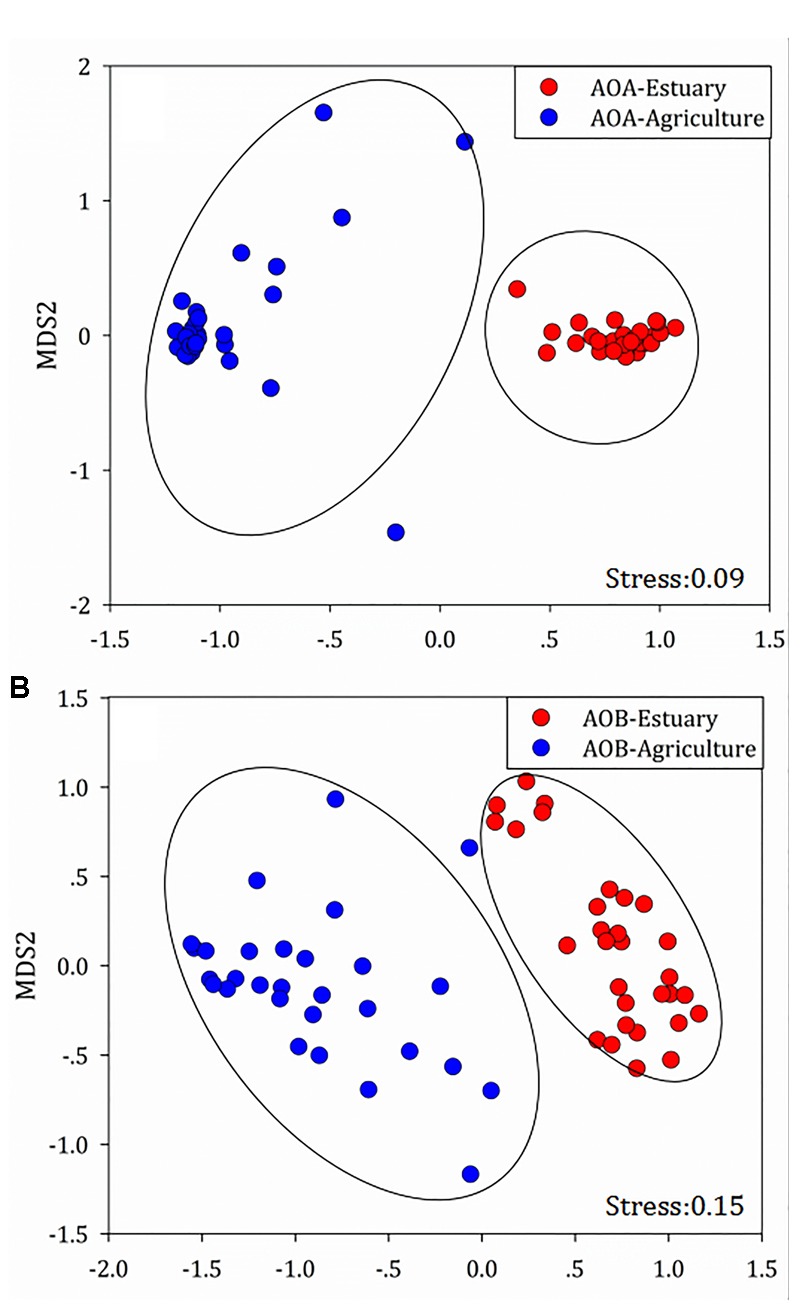
Compositional structure of (A) ammonia-oxidizing archaea (AOA) and (B) ammonia-oxidizing bacteria (AOB) 16S rRNA genes among the mudflat and agricultural sites as described by non-metric multidimensional scaling plots.